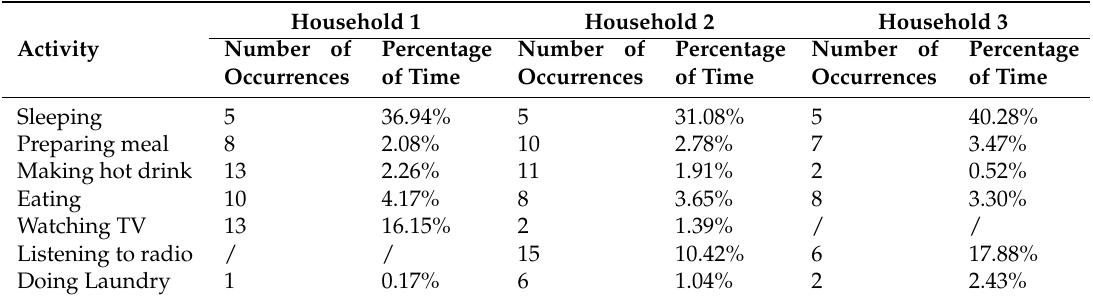
Table 5. Number of occurrences and time spent for each type of activity in the data